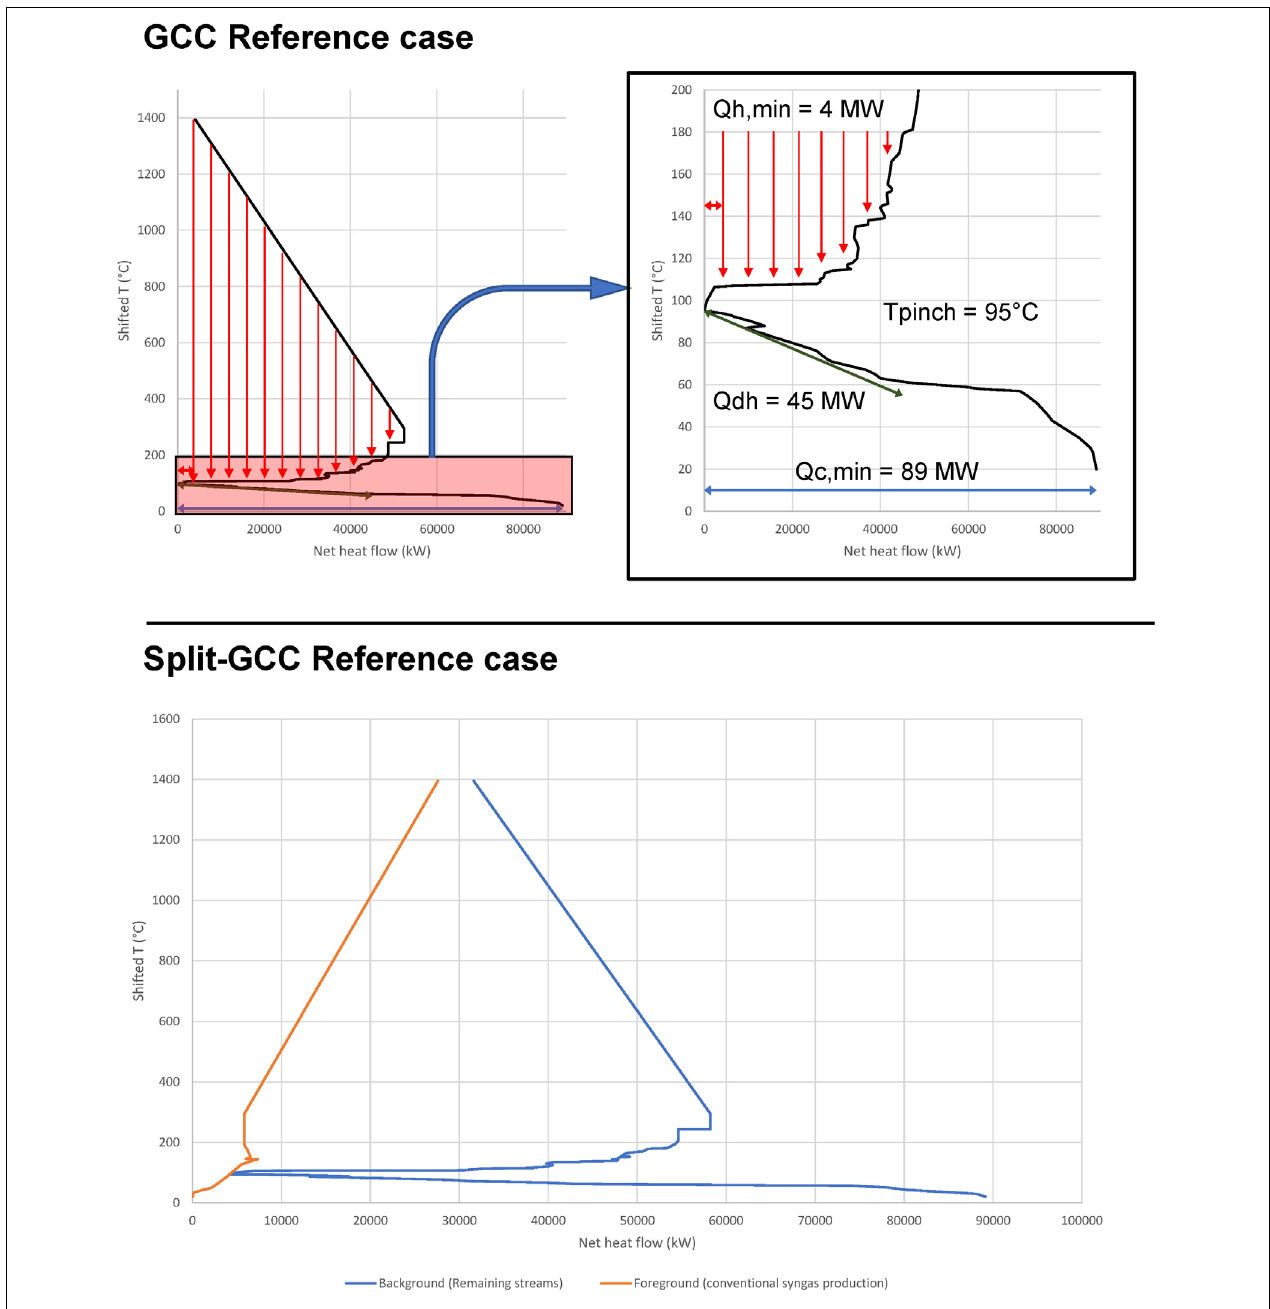
FIGURE 6 | GCC and split-GCC for the reference case. In the GCC, the minimum heating (Q h , min ) and cooling (Q c , min ) demands, as well as the district heating delivery potential (Q dh ) and the pinch temperature (T pinch ) are indicated. The red vertical arrows indicate heat flows within heat